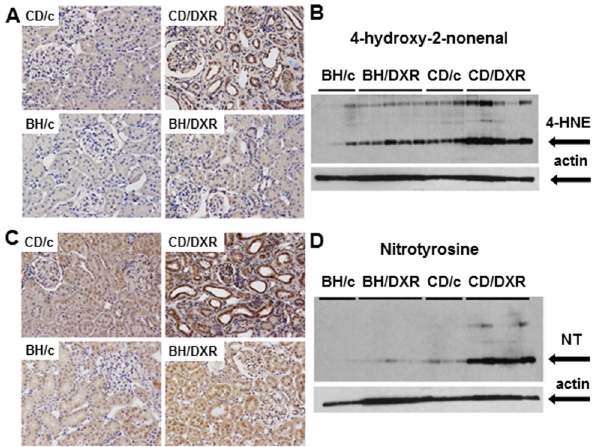
Western blot. CD: CD rats, BH: BH rats. c: saline-injected, DXR: Doxorubicin-injected rats (5 mg/kg).